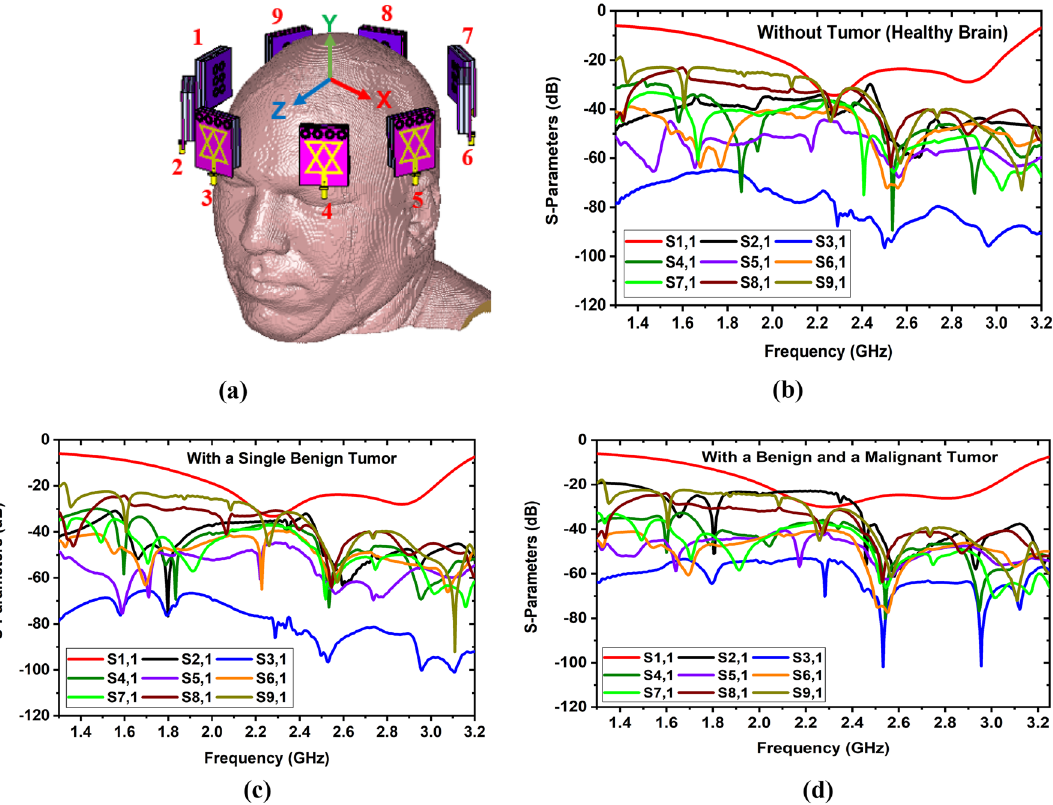
Figure 20. Simulated imaging setup and measurements: ( a ) Nine-antenna array setup with head; ( b ) S-parameters without tumor; ( c ) S-parameters with a single benign tumor; ( d ) S-parameters with a benign and a malignant